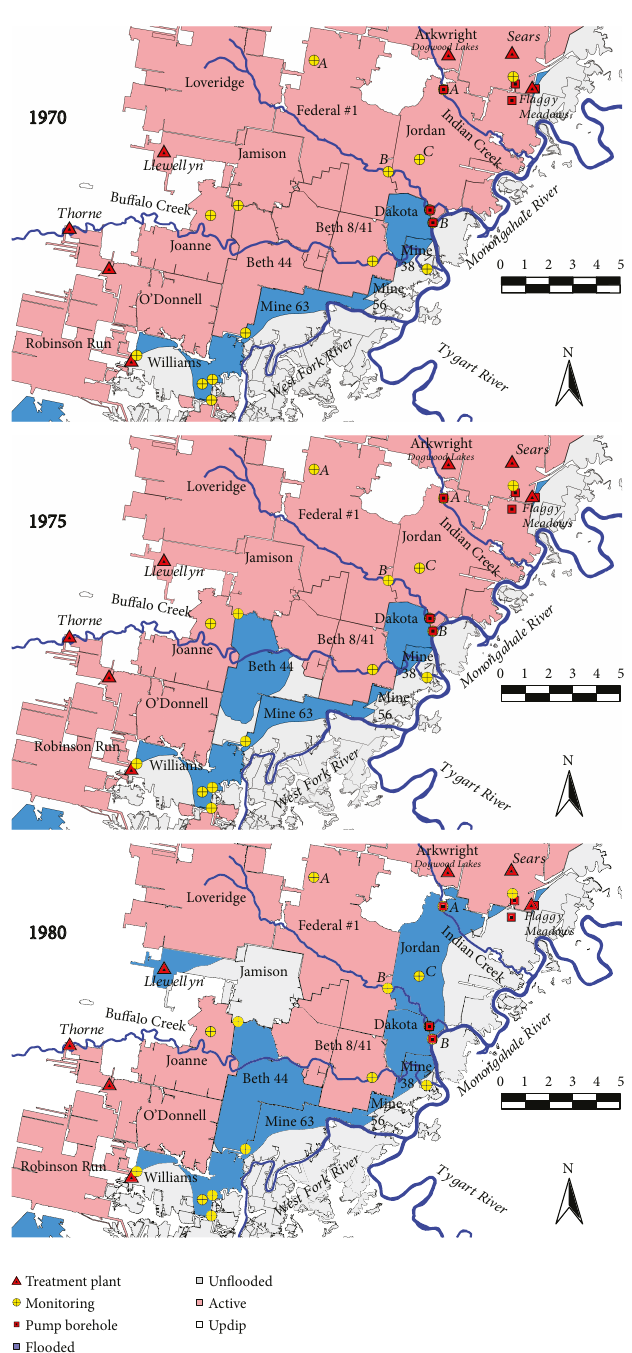
Figure 6: Flooding extent in closed mines, 1970 – 1980. Interior coal pillars are omitted for